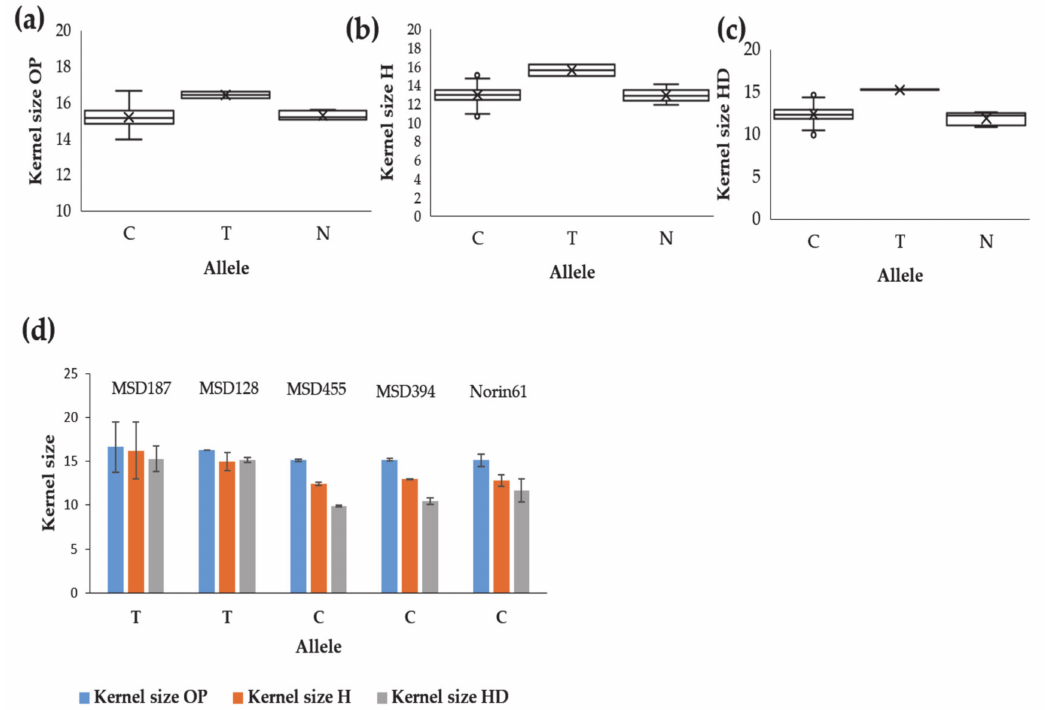
Figure 6. Effects of the alleles of the stable marker SNP_1073897|F|0-27 that increases kernel size under ( a ) optimum, ( b ) heat and ( c ) heat–drought conditions. ( d ) Examples of the lines harboring different alleles for SNP_1073897|F|0-27 and their parent Norin